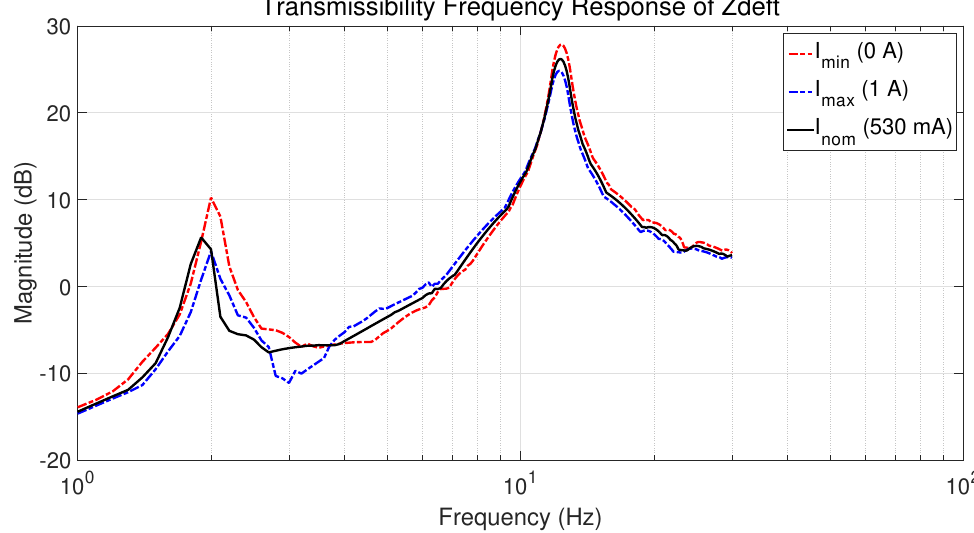
Figure 7. Comparison of TFR of the tyre deflection for different current